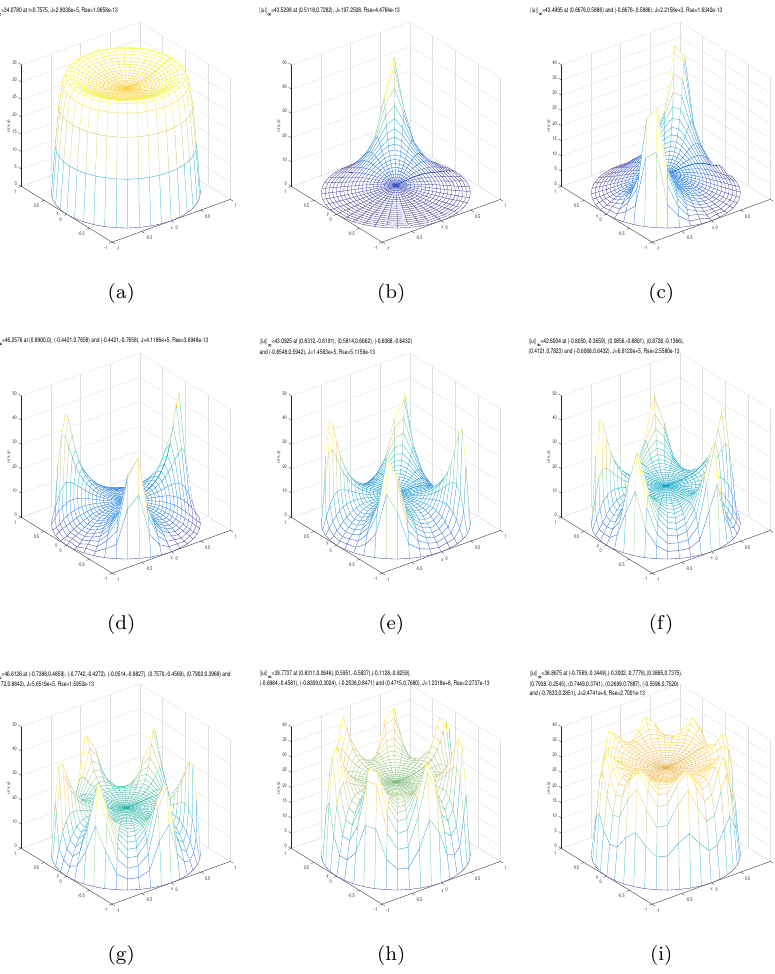
Figure 7. Nine positive solutions to problem (1.1) with p = 3 , l = 17 . 5 , λ = 1 and κ = − 1, which are O (2), Σ 1 , Σ d , D 3 , D 4 , D 5 , D 6 , D 7 and D 8 symmetric,